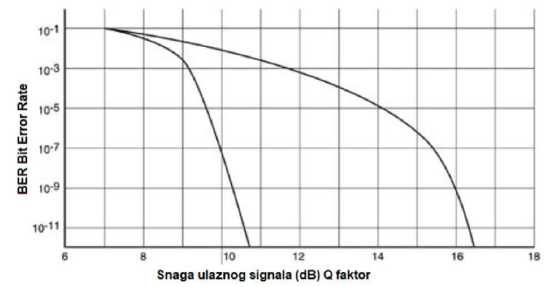
Figure 8. Relation of input signal and Q